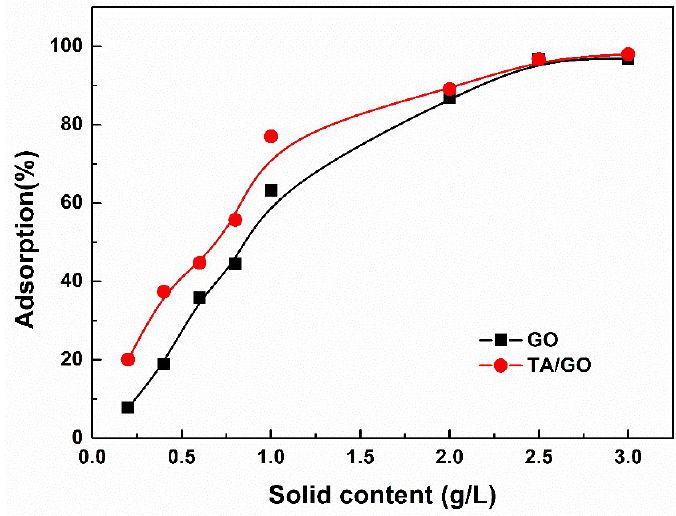
Figure 5. E ff ects of di ff erent solid contents at pH = 3.6 ± 0.05 and I = 0.001 M